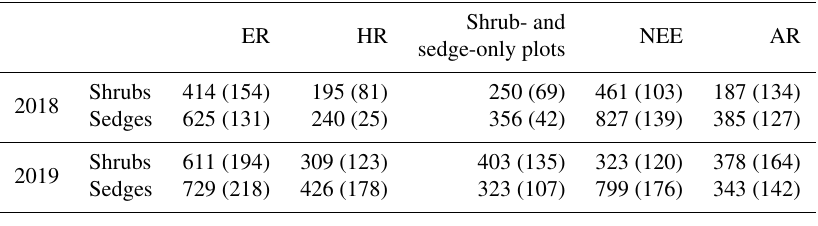
Table 2. Annual average ecosystem respiration (ER), autotrophic respiration (AR), heterotrophic respiration (AR), and net ecosystem ex- change (NEE) values for the shrubs and sedges in 2018 and 2019 ( ± SD).